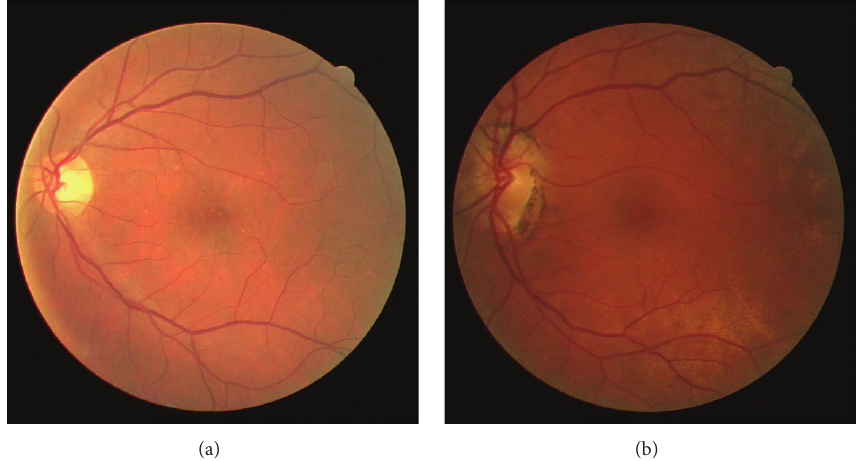
Figure 2: Retinal images from DRIVE: (a) normal image, (b) pathological